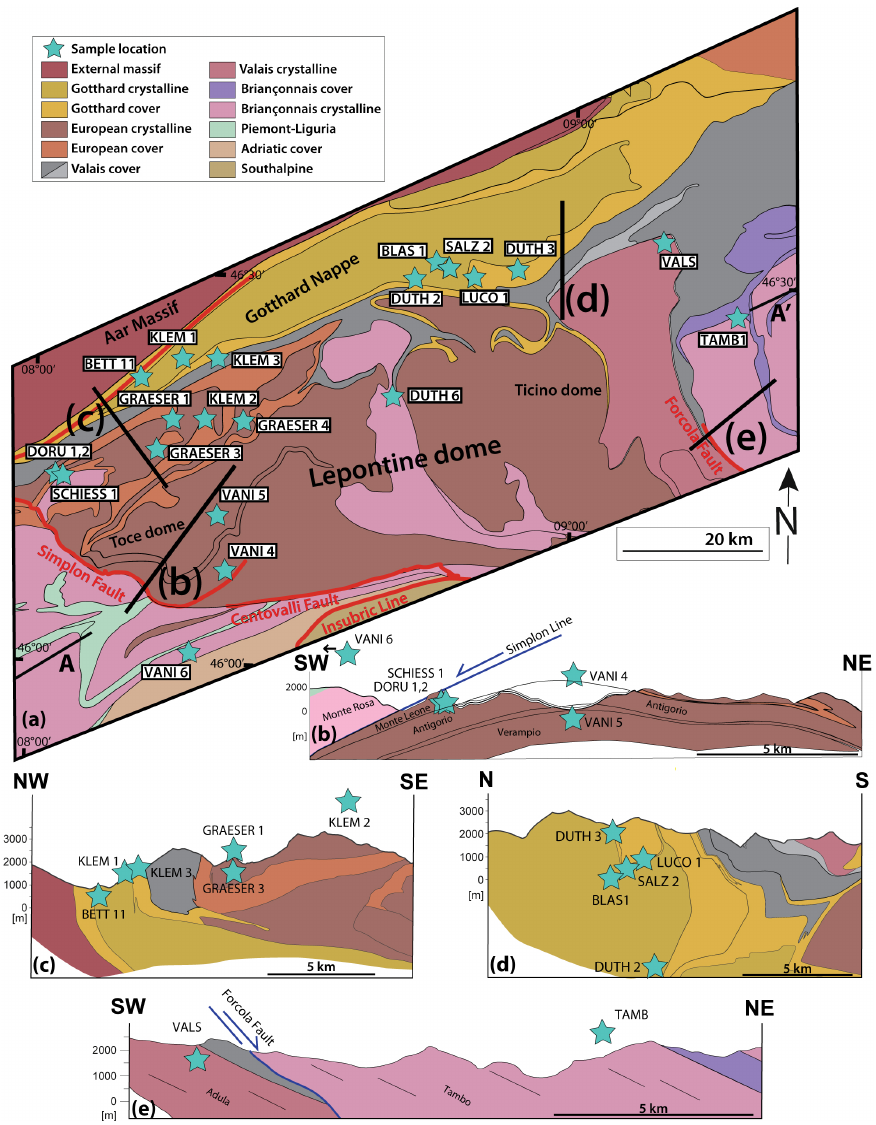
Figure 3. Tectonic overview over the study area. (a) Tectonic sketch map modified after Schmid et al. (2004) and Steck et al. (2013); (b) tectonic section over the Simplon Fault zone into the western Lepontine, based on Campani et al. (2014); (c) tectonic section through the western Northern Steep Belt, modified and extended after Leu (1986); (d) tectonic section through the eastern Northern Steep Belt, redrawn after Wiederkehr et al. (2008); (e) tectonic section across the Forcola normal fault; see also Meyre et al. (1998) and Berger et al. (2005). Profiles (b) – (e) are not to scale with map (a) . Section A–A (cid:48) is shown in Fig.